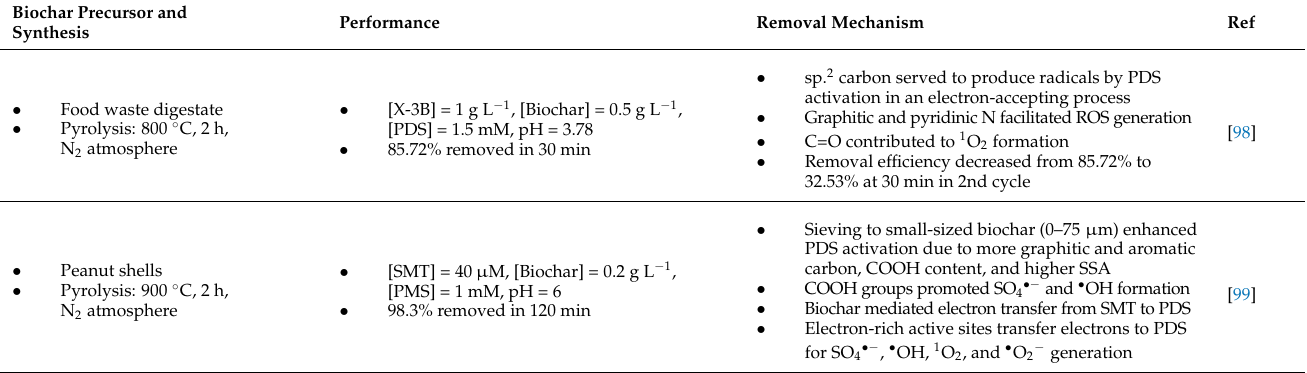
Table 4. An overview of biochar preparation and performance in PS activation for organic pollutants